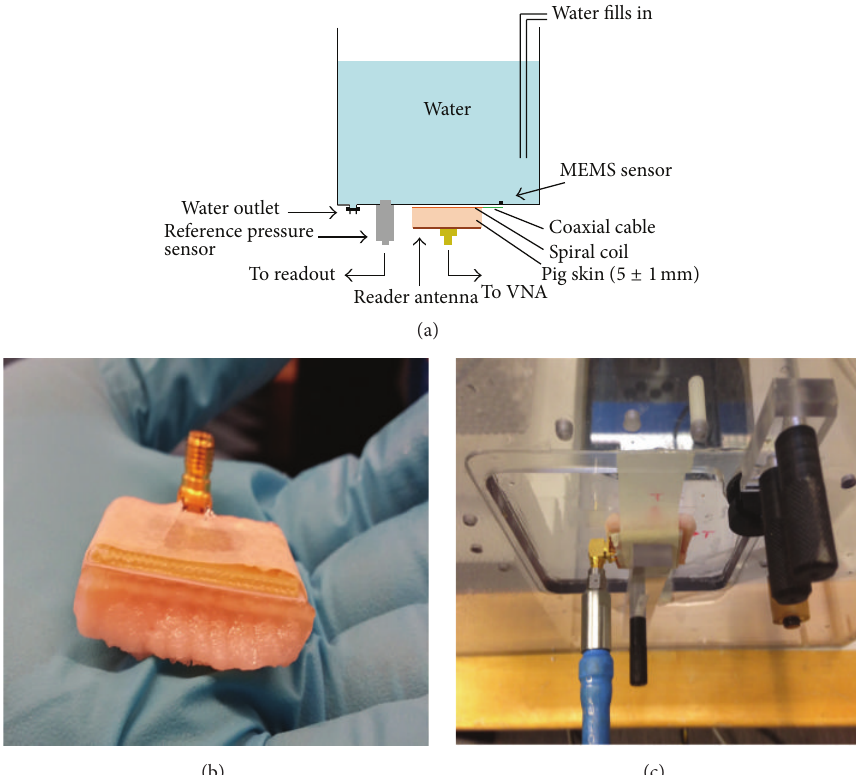
Figure 4: (a) Conceptual illustration of the measurement setup. (b) Pig skin attached to the reader antenna. (c) Reader